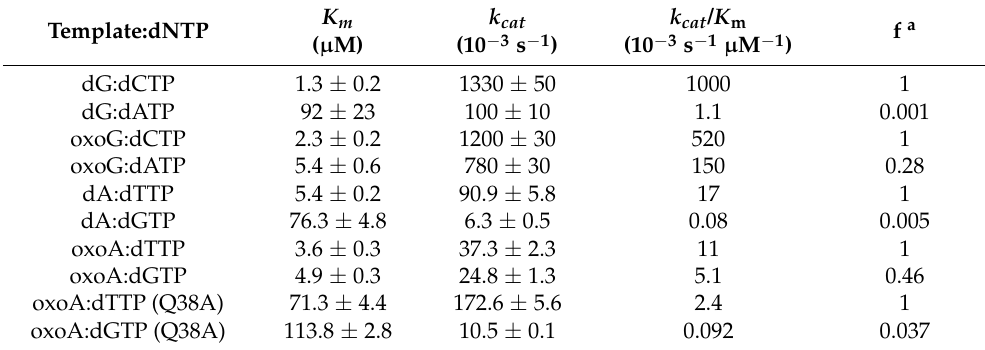
Table 4. Kinetic parameters for nucleotide incorporation opposite oxoG and oxoA by pol η [35,36,52].